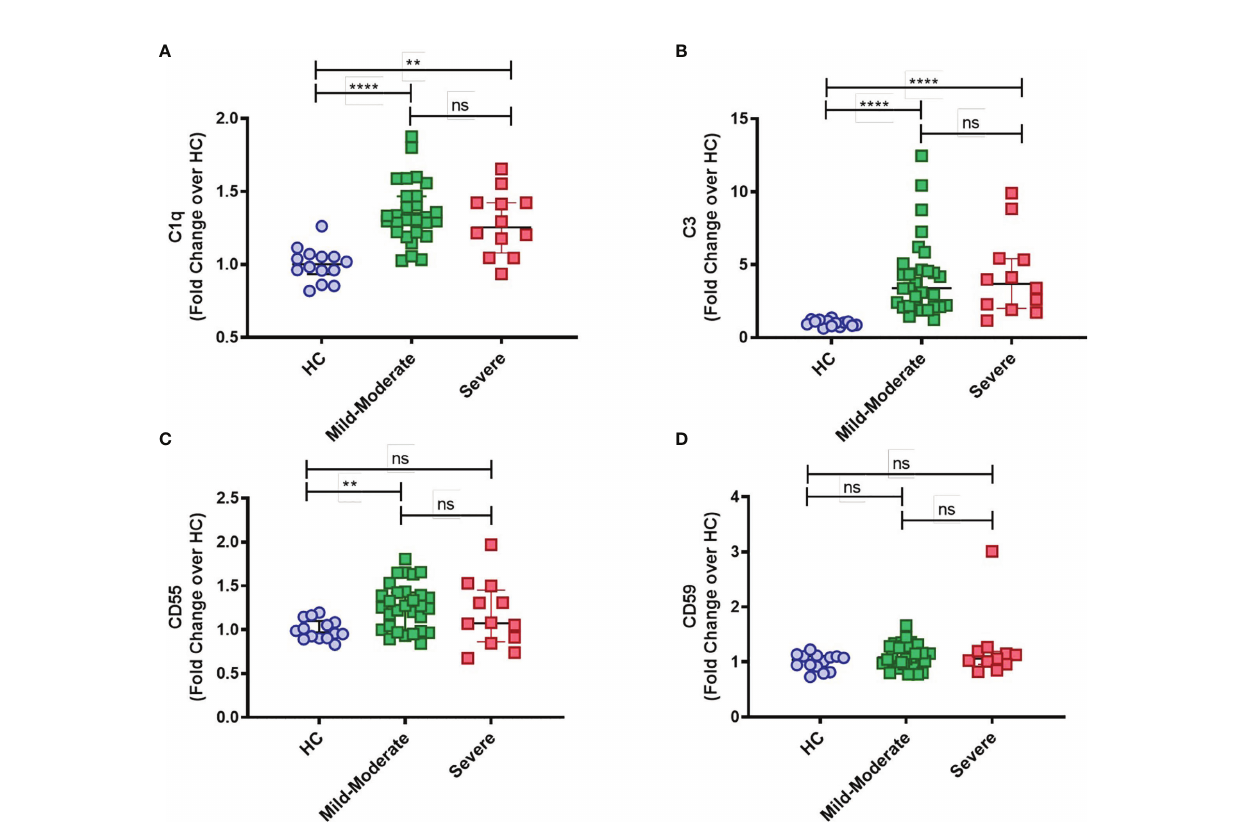
FIGURE 2 | Complement deposition on circulating blood monocytes from COVID-19 strati fi ed by disease status. The mean fl uorescence intensity (MFI) of C1q (A) , C3 (B) , CD55 (C) and CD59 (D) expression on circulating blood monocytes was compared among healthy controls (HC) (n = 14), COVID-19 Mild to Moderate patients (n = 30) and Severe patients (n = 12) by fl ow cytometry. Data are presented as Fold change over their respective experimental HC mean, and graphs depict median and interquartile range. Data were analyzed using the Kruskal-Wallis test. **P < 0.01, ****P < 0.0001; ns , not signi fi